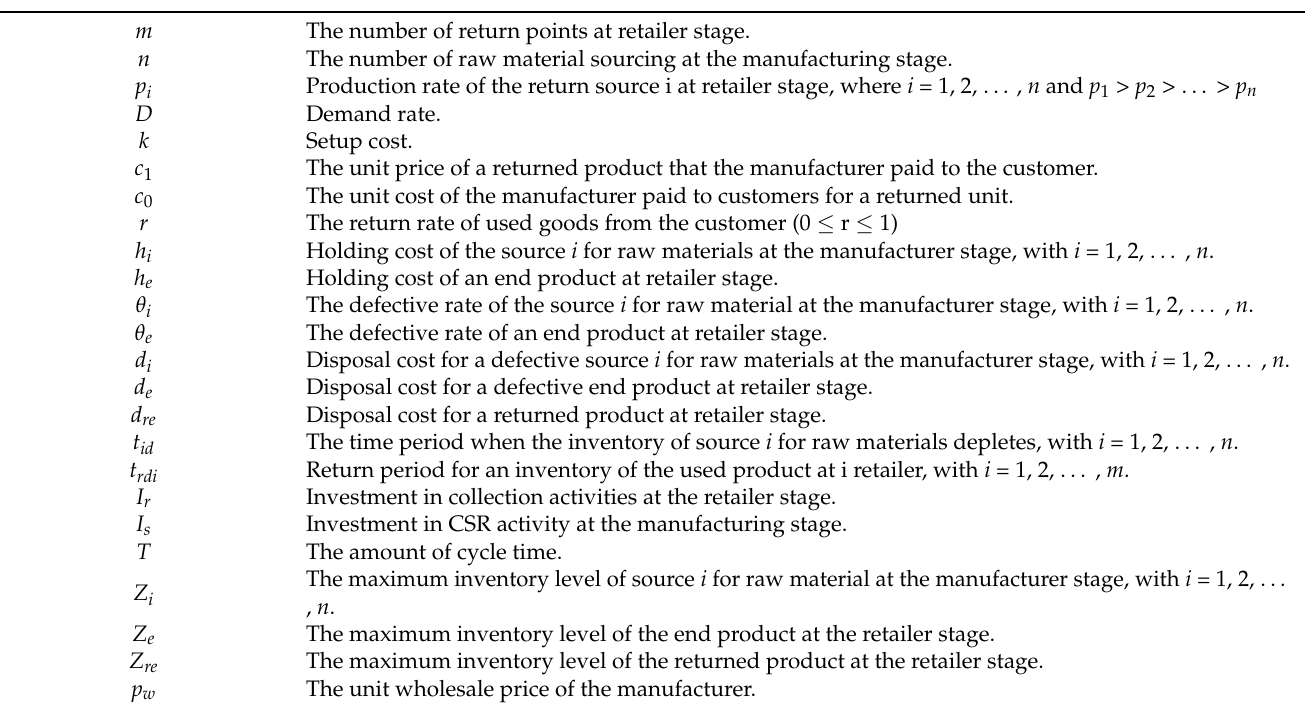
Table 1. System parameters of this